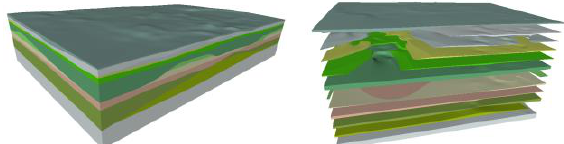
Figure 9. One stratum interface was constructed from the drill sample points and the bounding box model was split into two parts